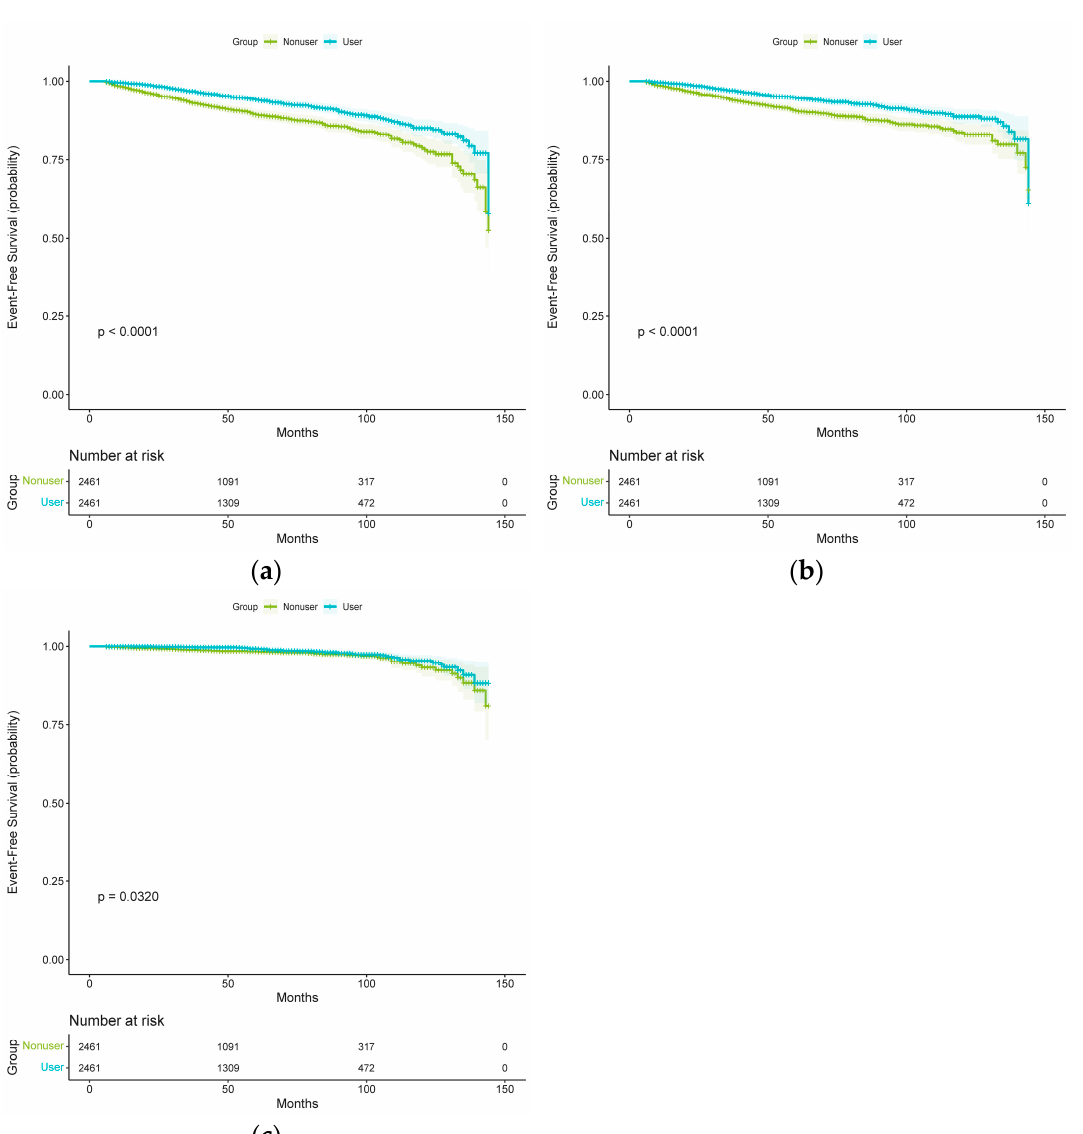
Figure 2. Kaplan–Meier curves for ( a ) total stroke, ( b ) ischemic stroke, and ( c ) hemorrhagic stroke in the spironolactone user and non-user groups (after propensity score matching).